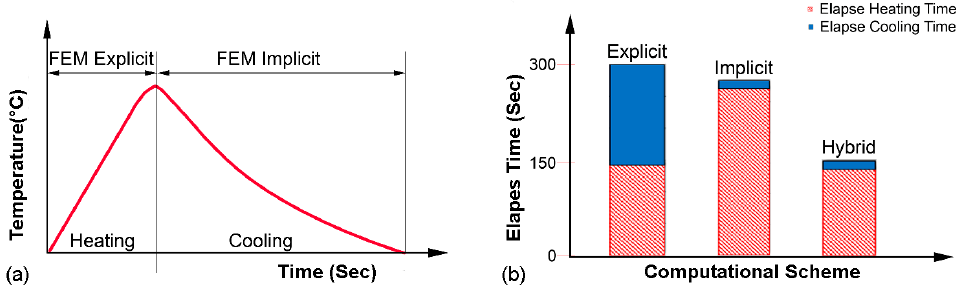
Figure 4. Hybrid FEM simulation. ( a ) Computational scheme in heating and cooling cycle. ( b ) Subsequent elapse time.